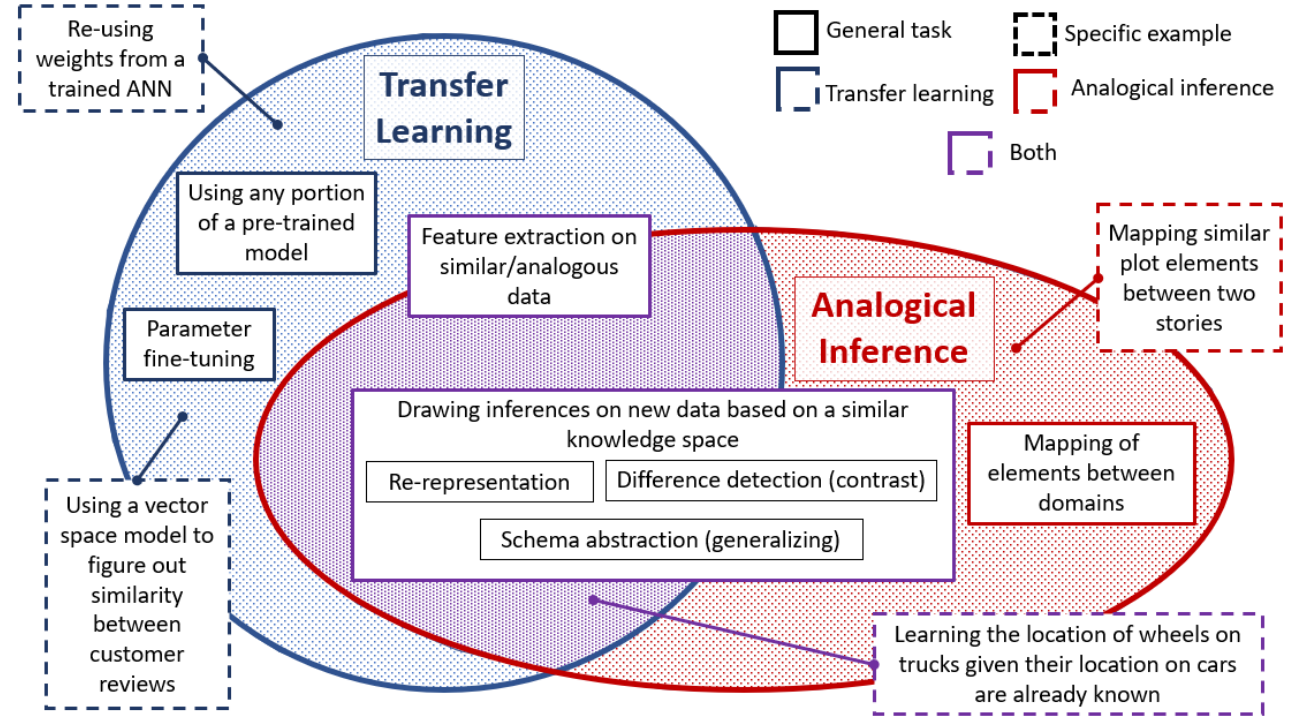
Figure 9. Venn diagram of separate and shared tasks and applications; blue denotes transfer learning tasks and examples, red denotes analogical inference tasks and examples, and purple denotes tasks and examples that may belong to either category.